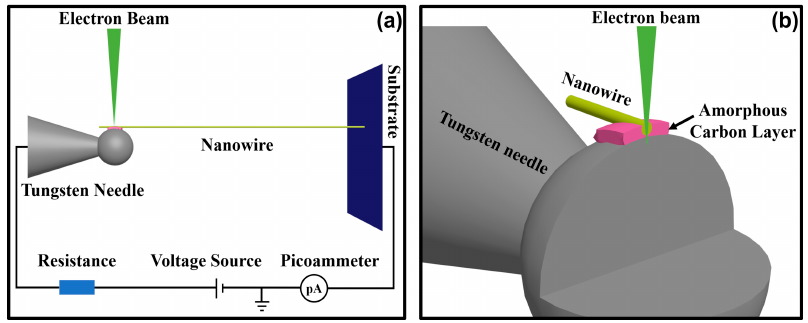
Figure 7. ( a ) Schematic diagram of the in-situ nanostructure welding process for an individual nanowire and its external circuit. ( b ) Schematic diagram of the structure inside the welded joints upon the nanostructure welding process.